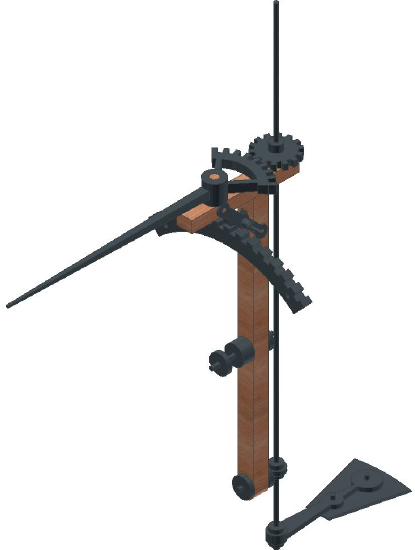
Figure 11. Axonometric view of the single-blade cutting mechanism.